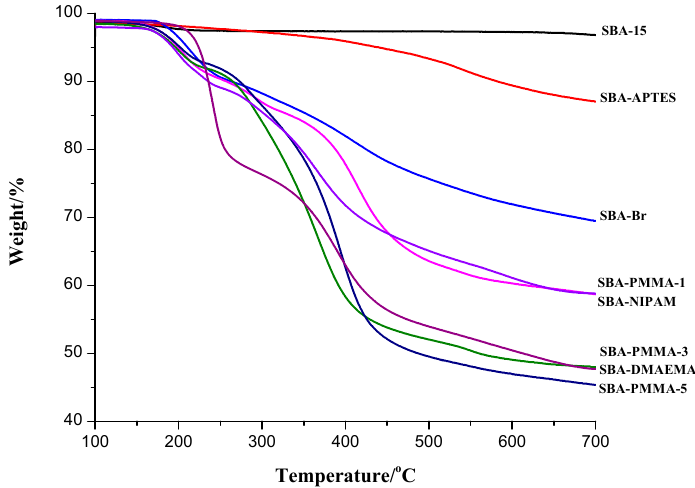
Figure 3. TGA curves of SBA-15; SBA-APTES; SBA-Br; SBA-PMMA; SBA-DMAEMA; and SBA-NIPAM. TGA was performed under the protection of N 2 at a heating rate of 10 ◦ C · min − 1 .